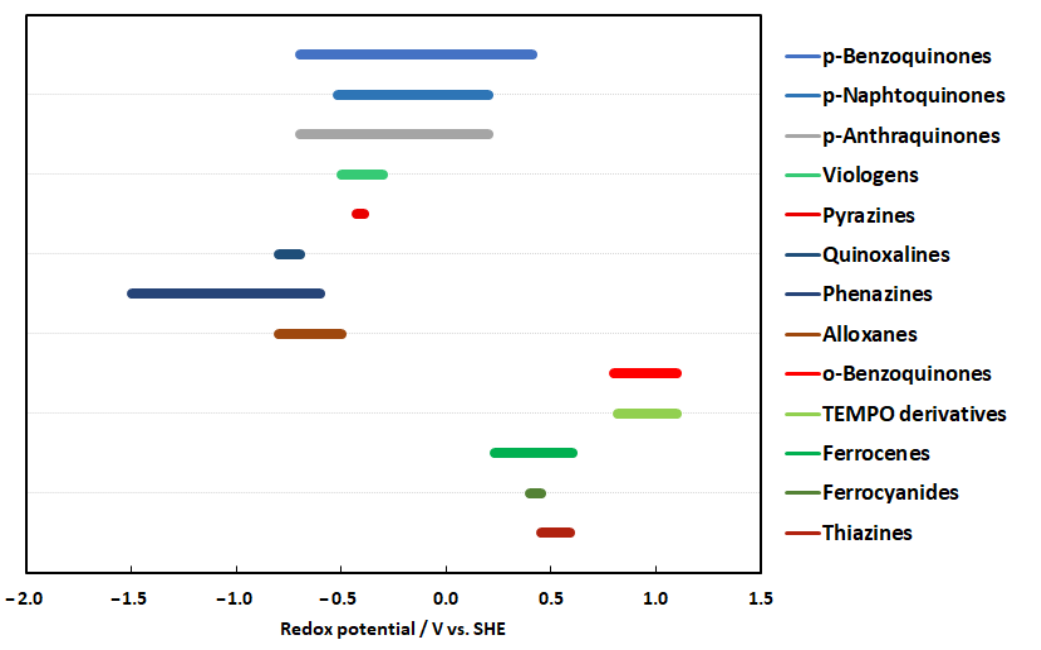
Figure 5. Redox potential ranges vs. SHE of redox couples discussed in this article. The color code of the bars indicates the pH regimes the redox potentials were measured in, red for acidic pH range, green for neutral, and blue for alkaline pH range, grey means that alkaline as well as acidic electrolytes were considered.